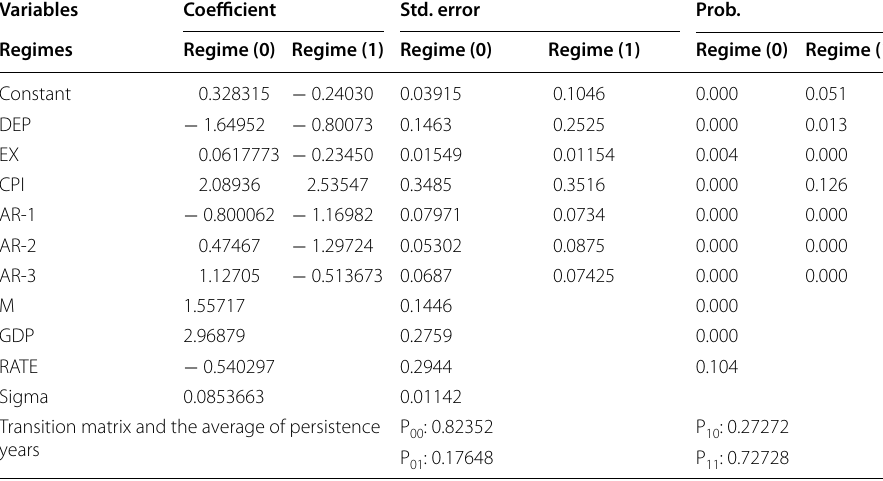
Table 5 The estimation results of equation